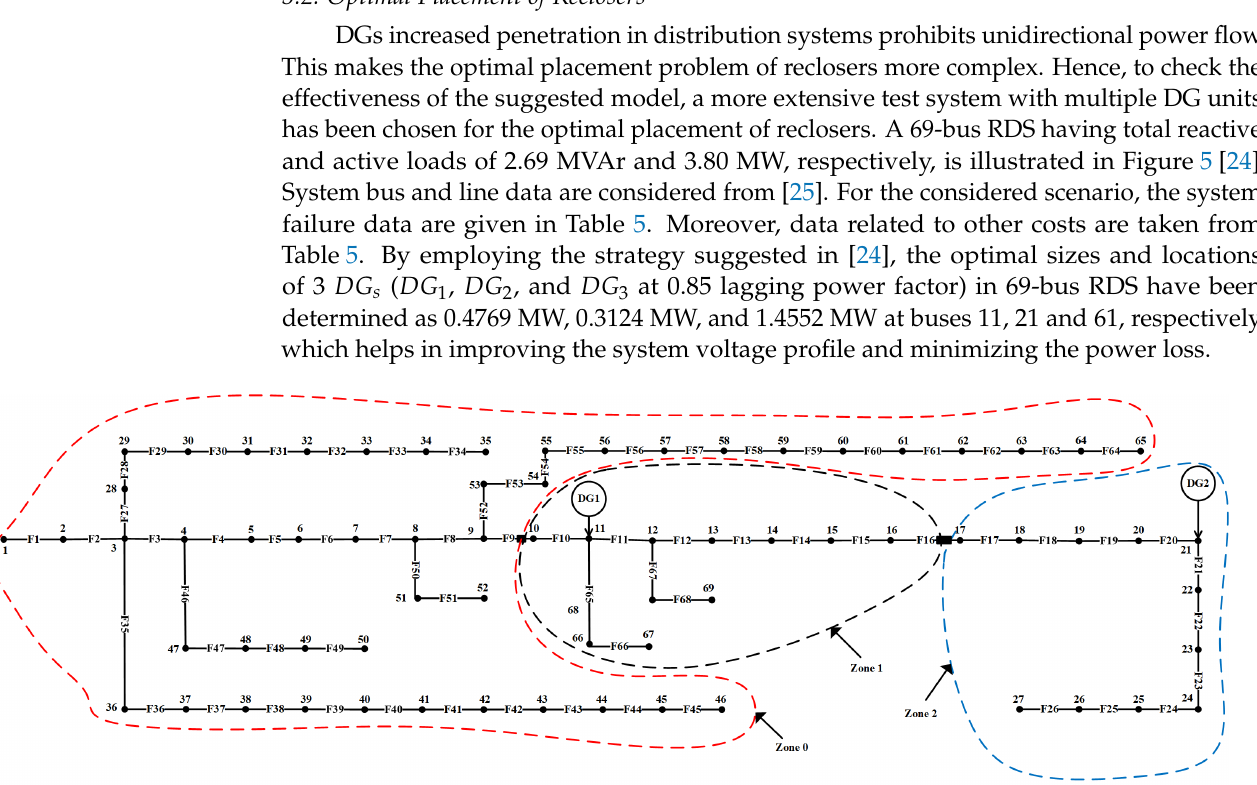
frequency and voltage control). It has been assumed that utility efficiently controls the security constraints and power balance in the